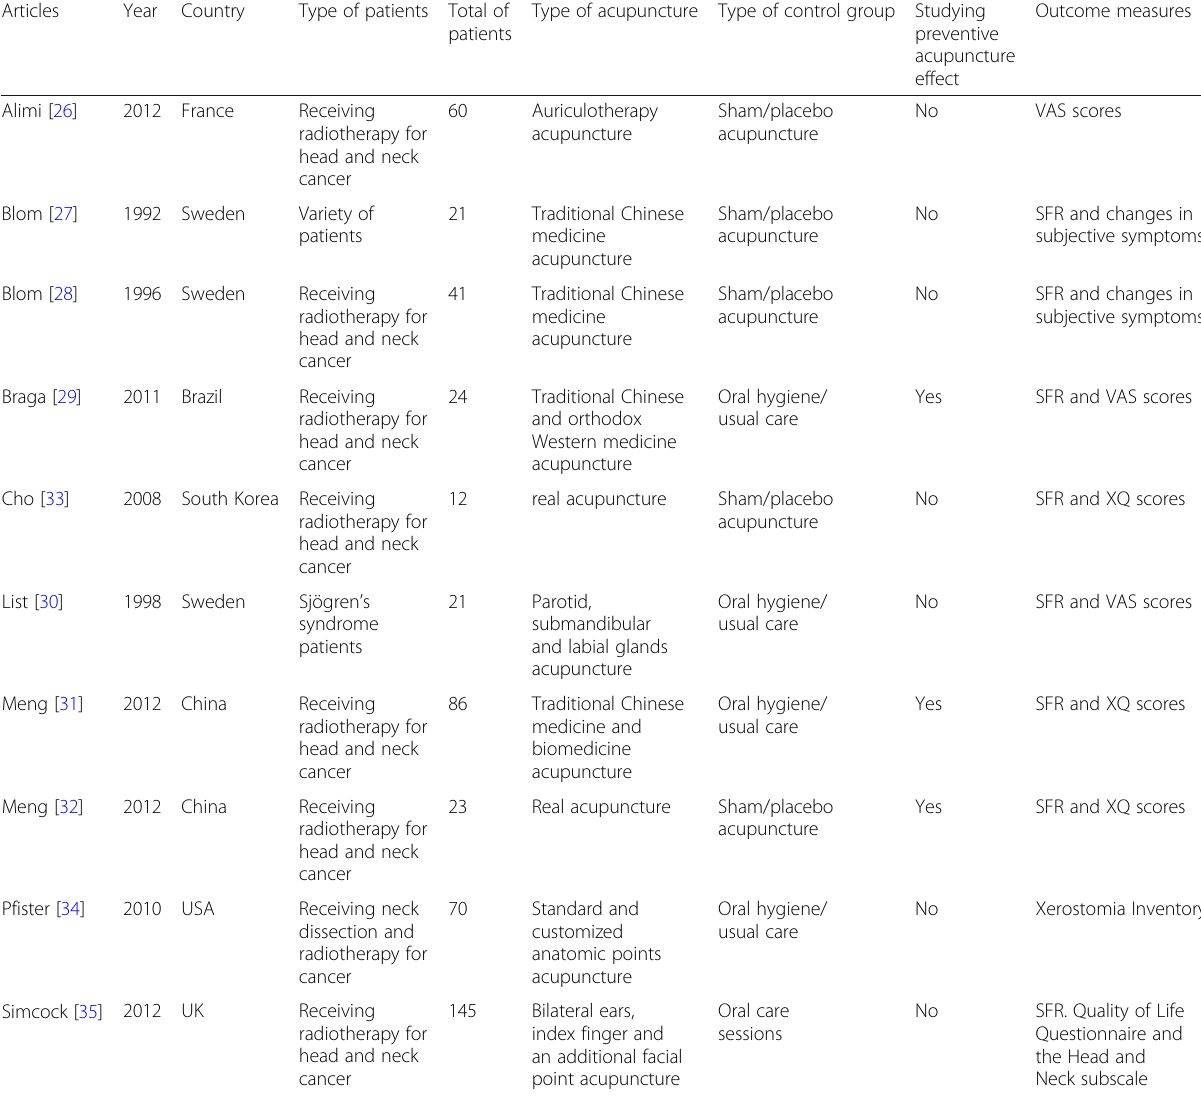
Table 2 This table shows the characteristics of the included randomised controled trials Articles Year